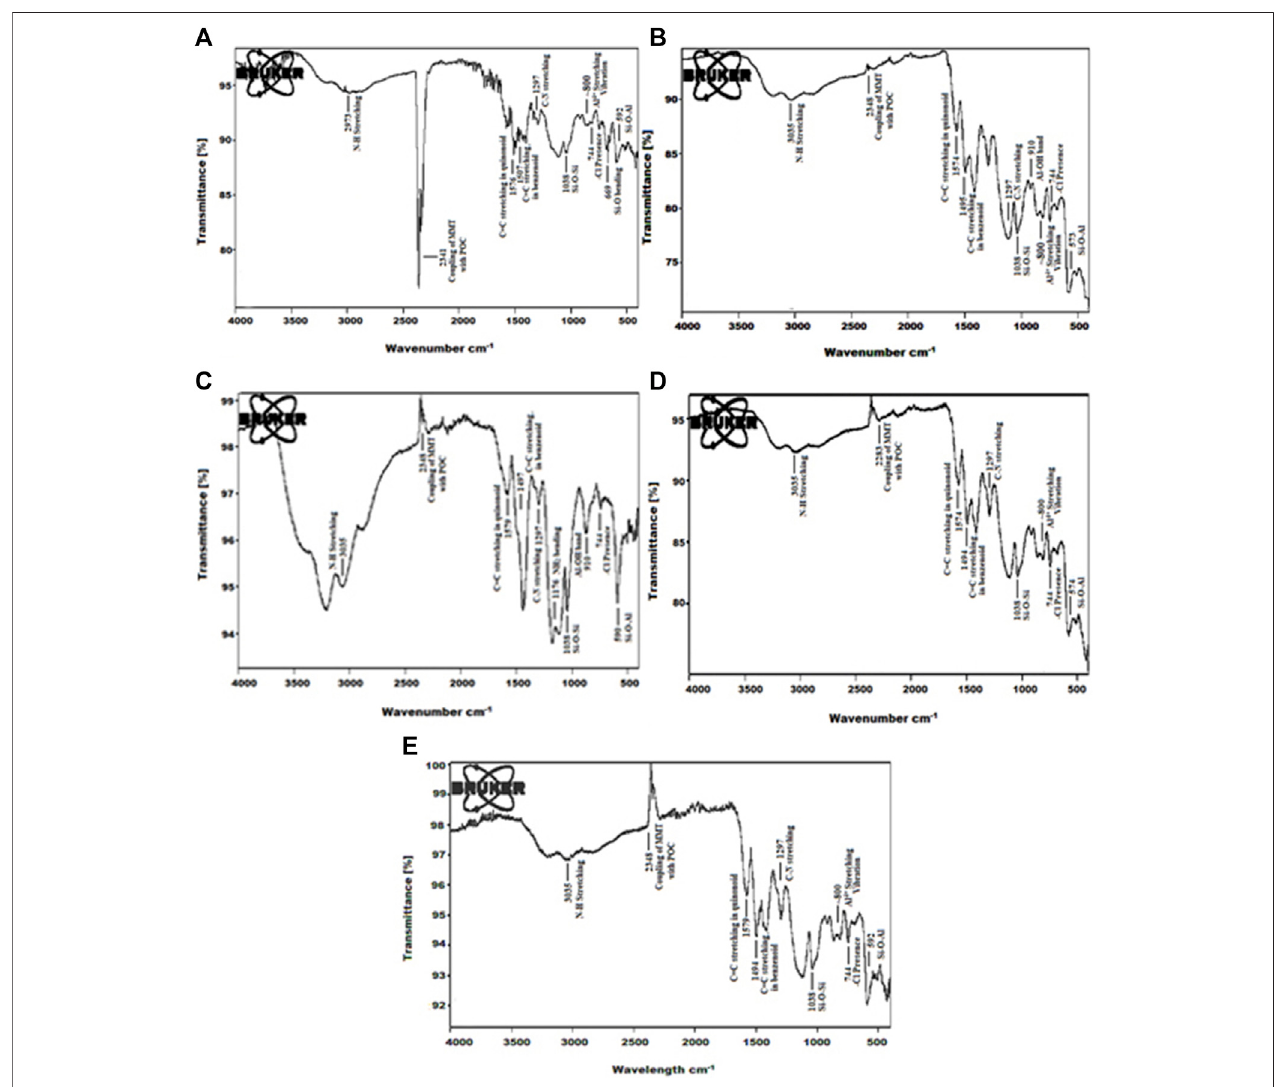
FIGURE 4 | FTIR (A) 1% POC/MMT (B) 3% POC/MMT (C) 5% POC/MMT (D) 7% POC/MMT (E) 10%